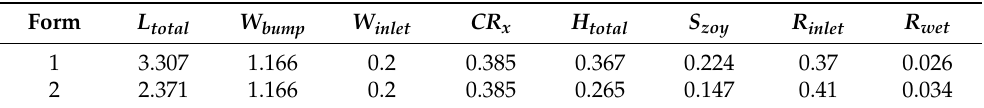
Figure 1. Configurations of two bump inlets ( upper side : side-spillage inlet, Form 2; lower side : central-spillage inlet, Form 1). Table 1. Geometric parameters of two diverterless hypersonic inlets (unit of length: m; unit of area: m 2 ).